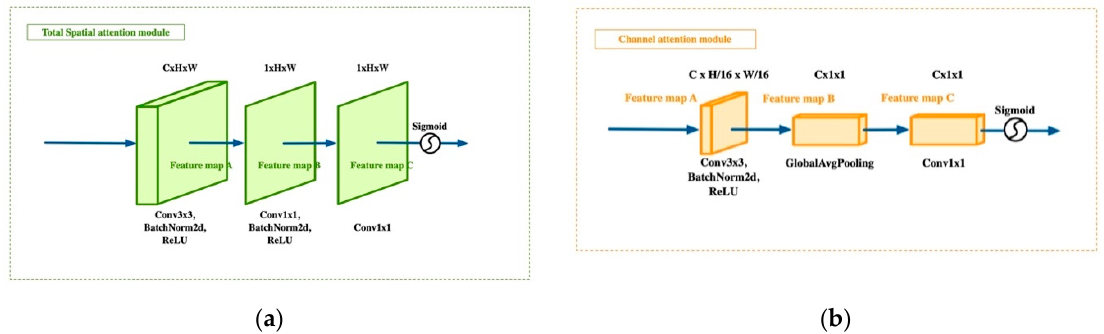
Figure 3. The two modules. ( a ) Total spatial attention module. ( b ) Channel attention module.